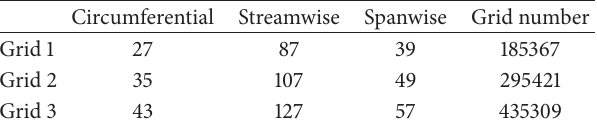
Table 2: Three grid